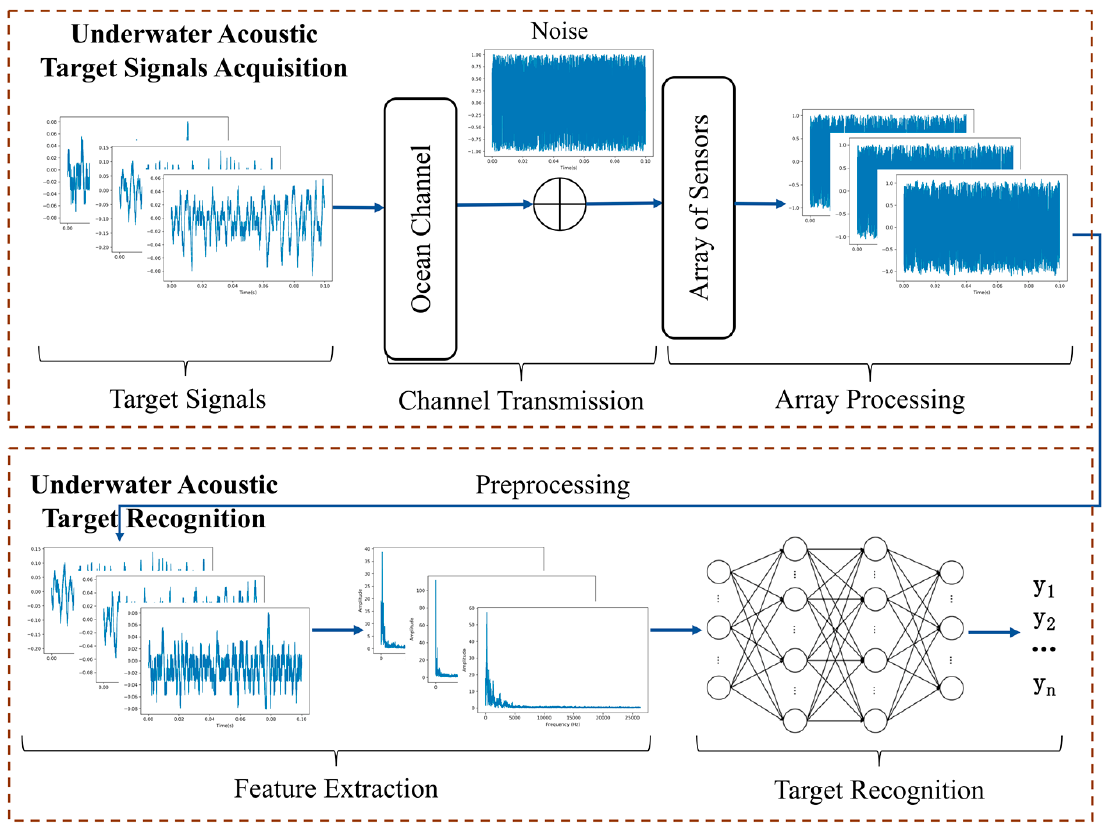
Figure 1. Flow chart of underwater acoustic signal acquisition and target recognition.